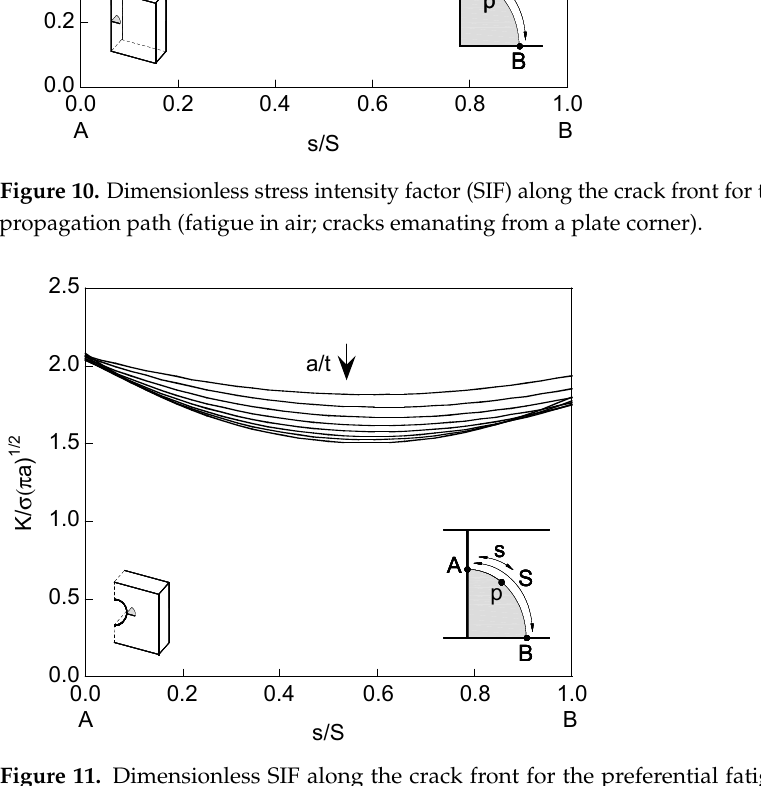
Figure 11. Dimensionless SIF along the crack front for the preferential fatigue propagation path (fatigue in air; cracks emanating from a hole with r = 2 t ).